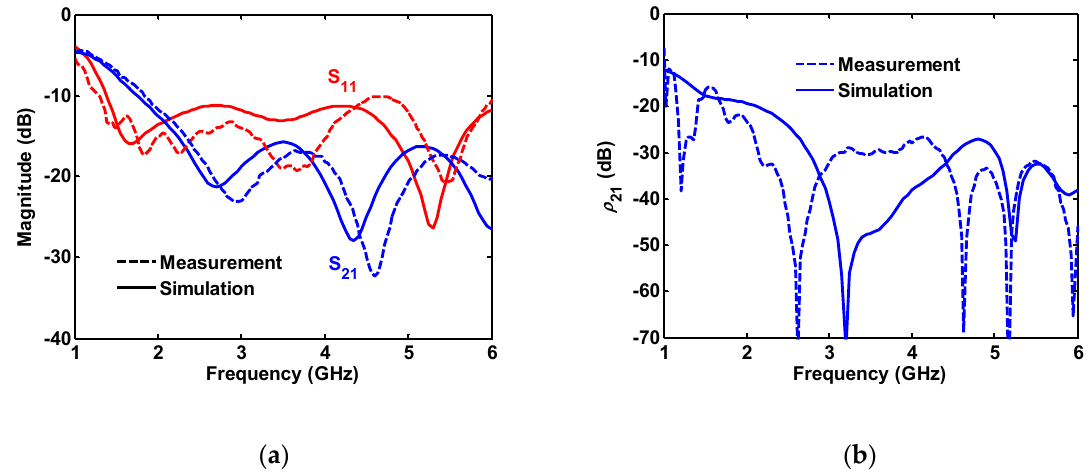
Figure 17. Measured and simulated ( a ) S-parameters and ( b ) correlation coefficient for two-port